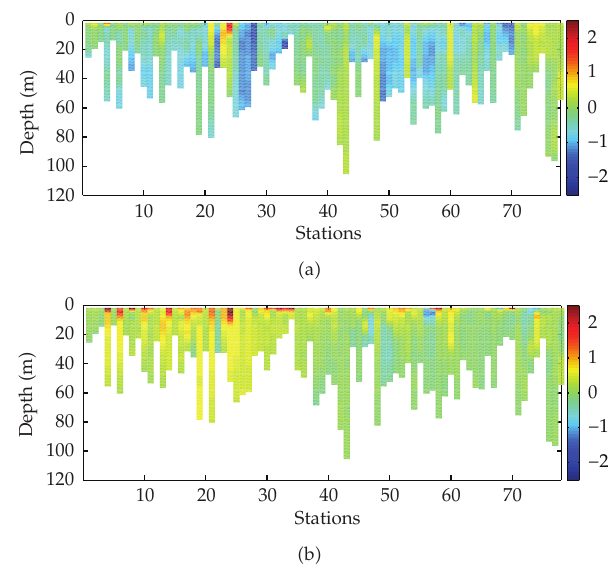
Figure 3: The di ff erences between measured and modelled (cid:4) ROMS (cid:5) temperature (cid:4) a (cid:5) and salinity (cid:4) b (cid:5) along CTD vertical profiles (cid:4) March 2008 (cid:5)